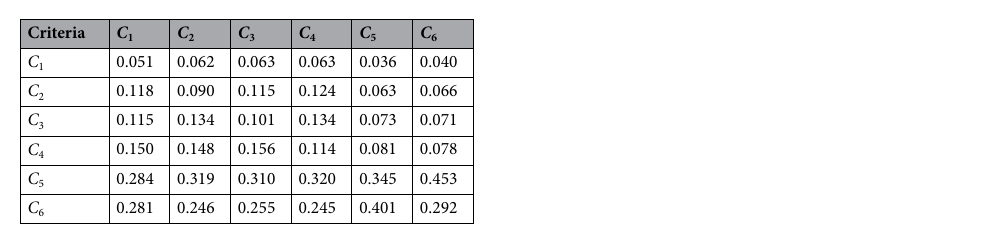
Table 6. The weighted supermatrix W α = T α D W .